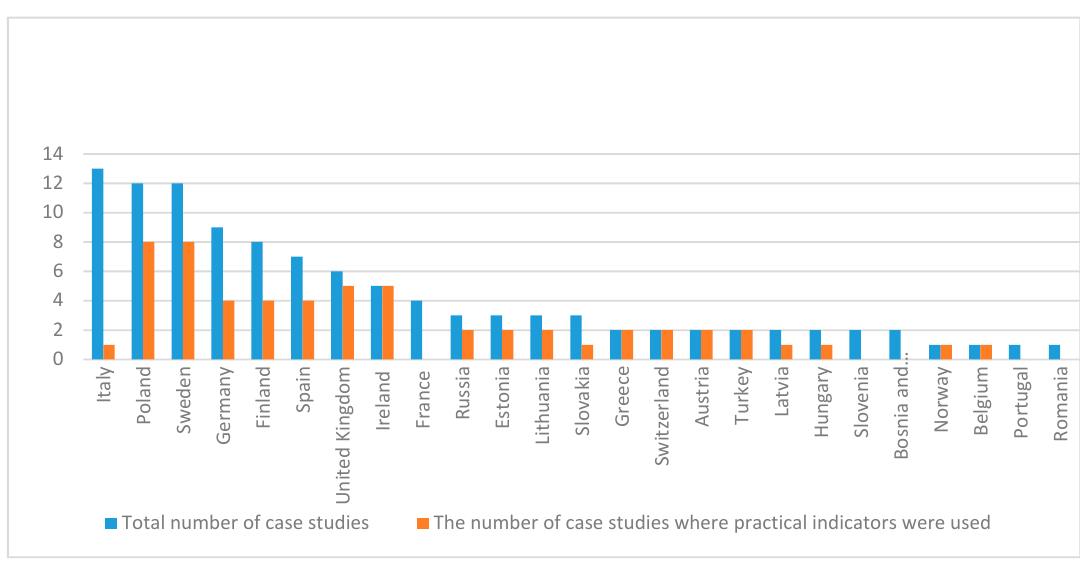
Figure 3. Ratio of the total number of case studies and the number of case studies that were addressing the practicality of the biodiversity indicators used. Analysis per country.